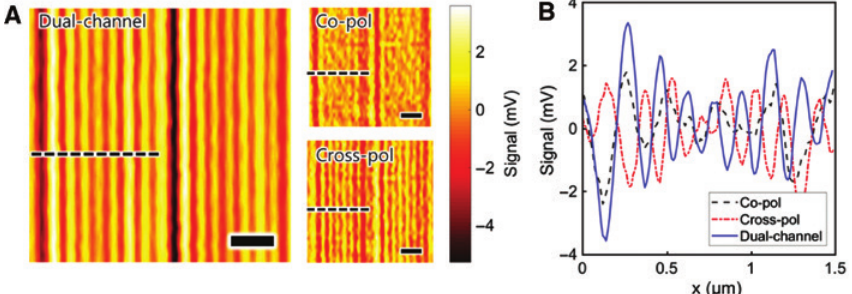
/air line array pattern in dynamic random access memory (DRAM) patterns using the plasmonic near- Figure 6: Imaging results of the SiO 2 field scanning nanoscope (PNSN) in noisy conditions.